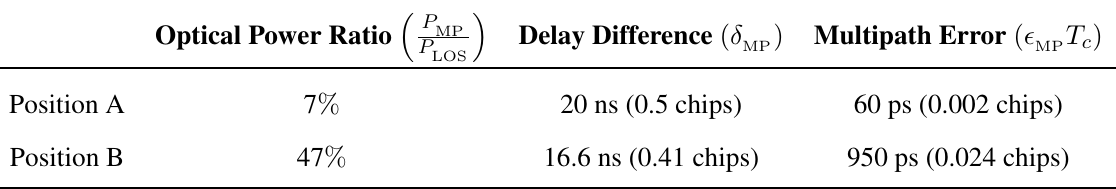
Table 2. Delays and optical power ratios associated to LOS and NLOS paths in point A and B of Figure